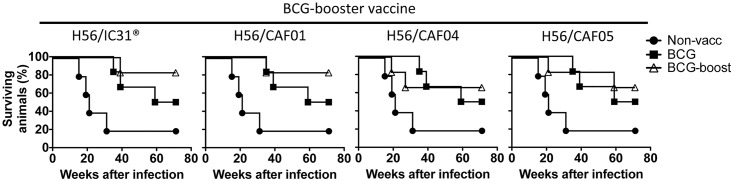
Boosting BCG with H56 improves survival after Mtb infection.Kaplan-Meier survival curves of the different BCG-booster vaccine groups (open triangles) are shown against the non-vaccinated group (filled circles) and BCG only group (filled squares). Symbols indicate euthanasia events.